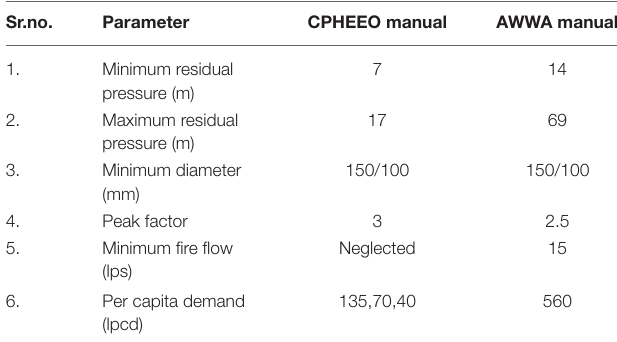
TABLE 5 | Design norms for WSS in India and the USA.